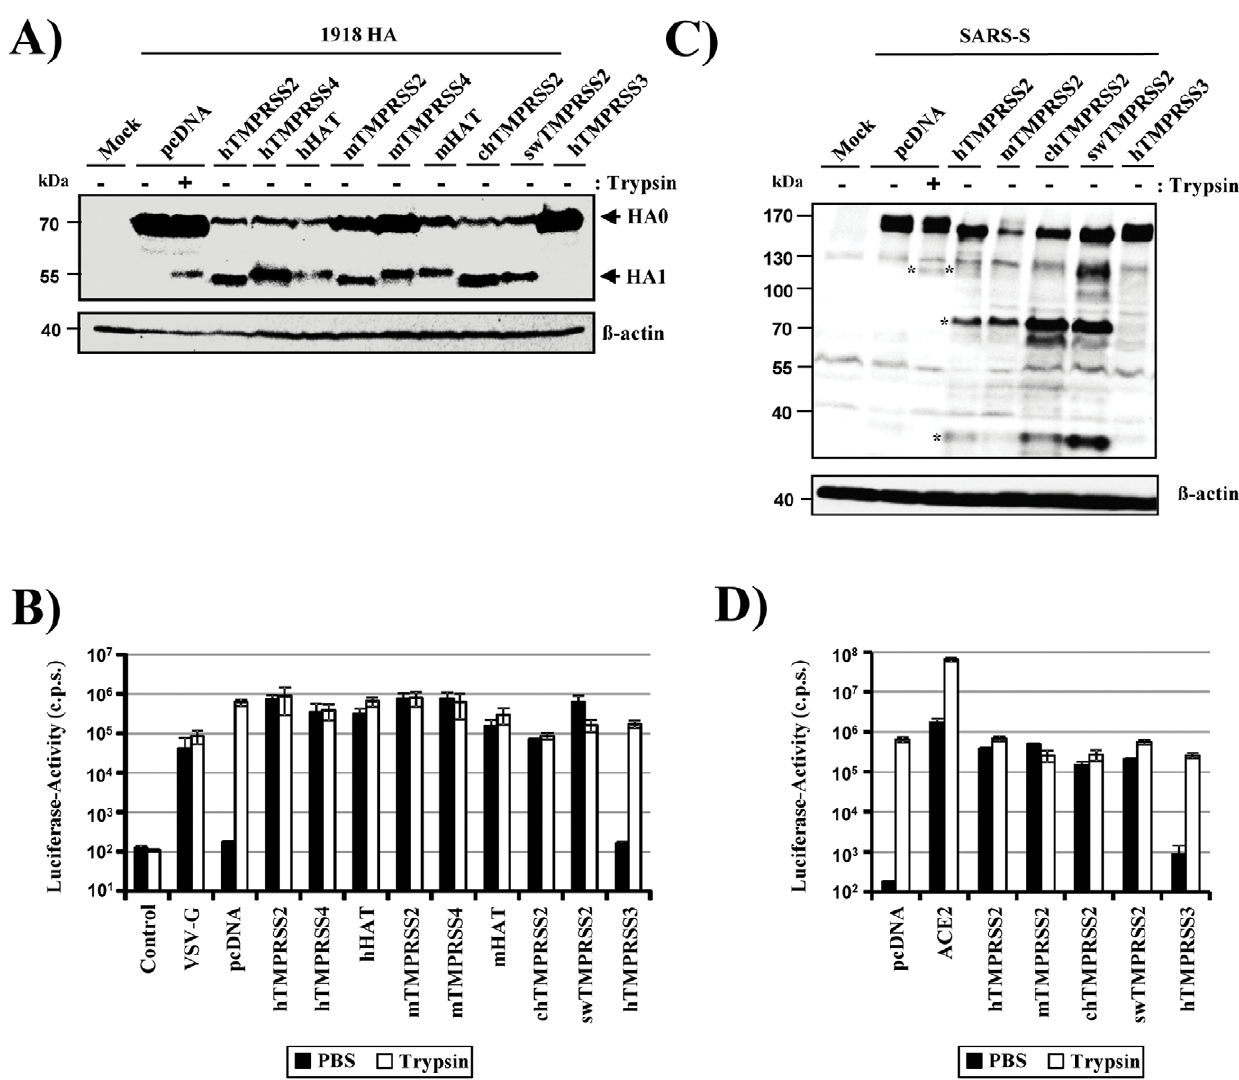
Figure 1. Proteolytic activation of influenza virus hemagglutinin and SARS spike protein is conserved between TMPRSS2 of human, porcine, avian and murine origin. (A) Expression plasmids encoding the HA of the 1918 influenza virus and the indicated proteases or empty vector (pcDNA) were transiently cotransfected into 293T cells. The cells were then treated with PBS or trypsin, and HA cleavage was detected by Western blot analysis of cell lysates using a monoclonal antibody specific for HA. Detection of ß-actin served as loading control. (B) Lentiviral reporter viruses bearing 1918 HA and NA or the VSV-G glycoproteins were generated in 293T cells coexpressing the indicated proteases or empty vector (pcDNA), treated with PBS (black bars) or trypsin (white bars), and used for infection of 293T target cells. Viruses harboring no glycoprotein were generated in parallel as control. Luciferase activities in the cell lysates were determined at 72 h post infection. The results of a representative experiment performed in triplicates are shown. Error bars indicate standard deviation (SD). Comparable results were obtained in a separate experiment. (C) To detect SARS-S cleavage in cis, expression plasmids coding for SARS-S and the indicated proteases or empty vector (pcDNA) were transiently cotransfected into 293T cells, which were then treated with trypsin or PBS. Subsequently, S-protein cleavage was detected by Western blot analysis of cell lysates using a serum specific for the S1 subunit of SARS-S. SARS-S cleavage fragments produced by trypsin and TMPRSS2 are indicated by asterisks. Detection of ß-actin served as a loading control. (D) Effector 293T cells were cotransfected with a SARS-S expression plasmid and a plasmid encoding GAL4-VP16 and mixed with target cells cotransfected with a plasmid encoding a GAL4-VP16 responsive luciferase expression cassette and an ACE2 expression plasmid or protease expression plasmid or empty plasmid. The effector and target cells were mixed, treated with PBS (black bars) or trypsin (white bars) and the luciferase activities in cell lysates quantified at 48 h after cell mixing. The results of a representative experiment performed in triplicates are shown. Error bars indicate standard deviation (SD). Similar results were observed in two independent experiments.